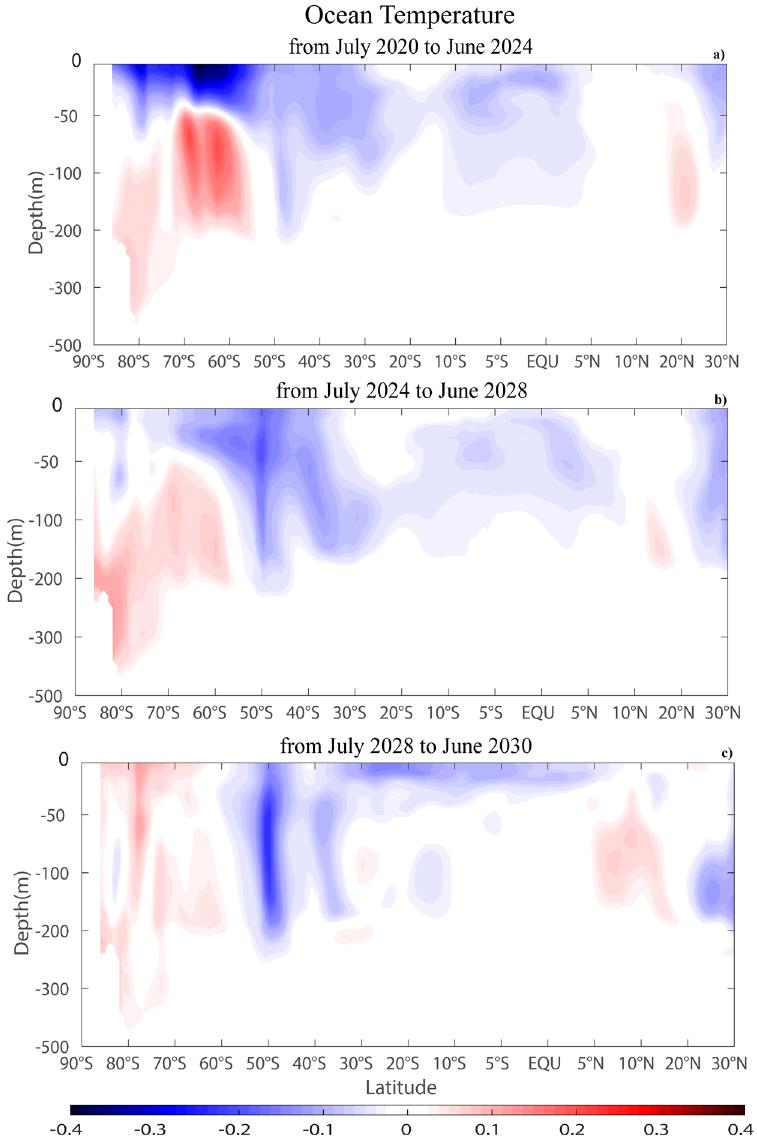
Figure 2. Zonal mean vertical (0–500 m) profile of ocean temperature differences ( layermax– layerctl ) extending from 90°S to 30°N during the periods: a)